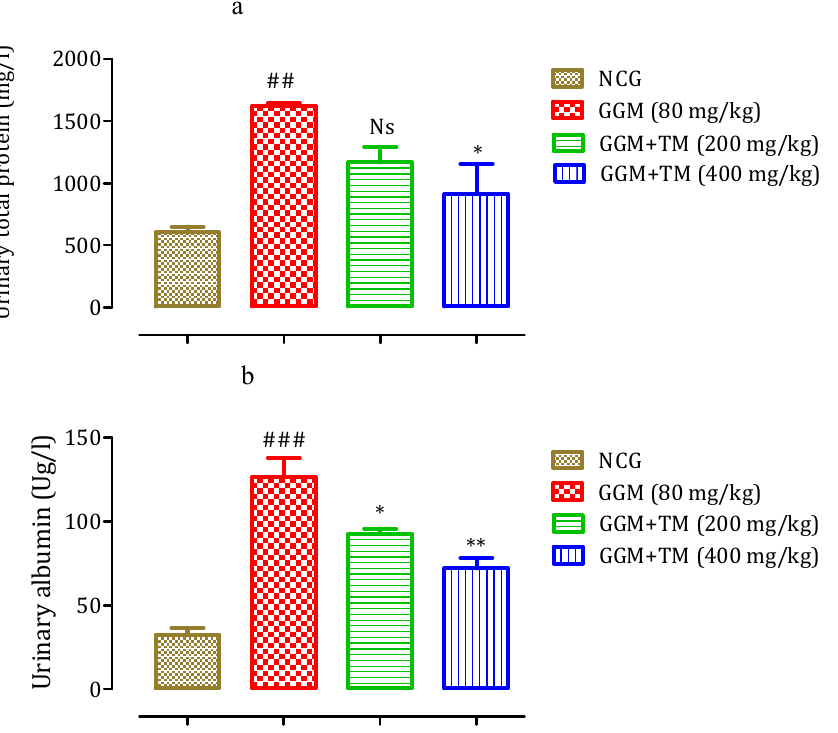
Figure 5. Effect of APTM on total urinary protein ( a ) and albumin ( b ) in GM-poisoned rats. Data are given as means ± SEM, (n = 6). ### p < 0.001, ## p < 0.01 related to NCG . * p < 0.05, ** p < 0.01 compared to GGM (80 mg/kg, b.w). Ns: not significant.